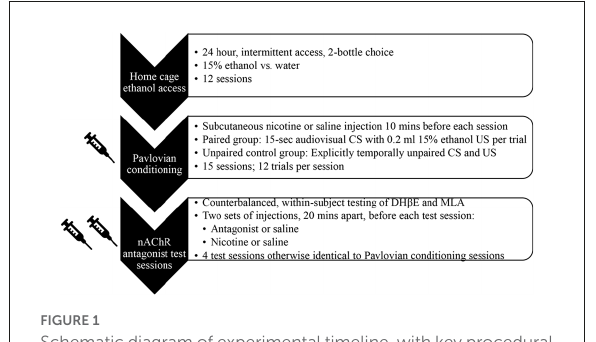
FIGURE1 Schematic diagram of experimental timeline, with key procedural details of each